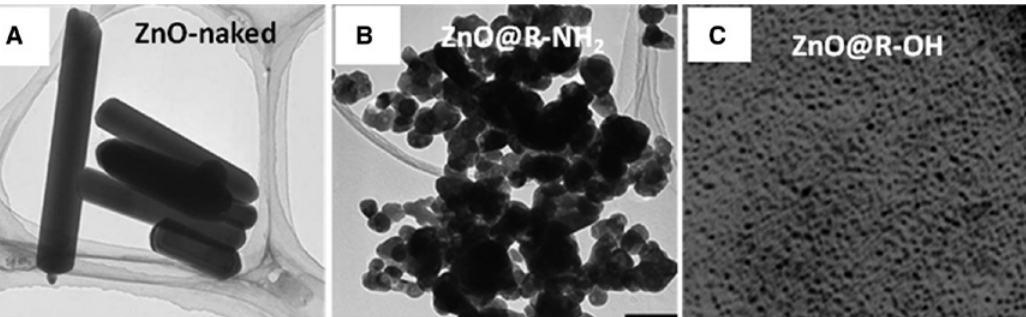
Figure 20: Hydrothermal synthesis of ZnO without (A) (reprinted with permission from Ohara S, Mousavand T, Sasaki T, Umetsu M, Naka